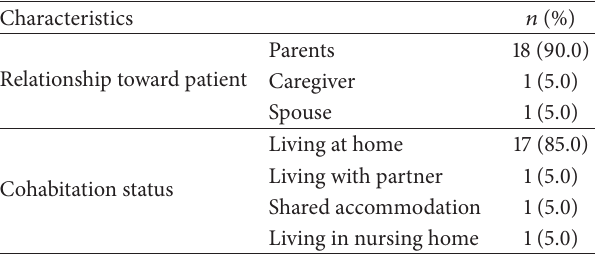
Table 2: Status of patient and significant others ( 𝑛 = 20